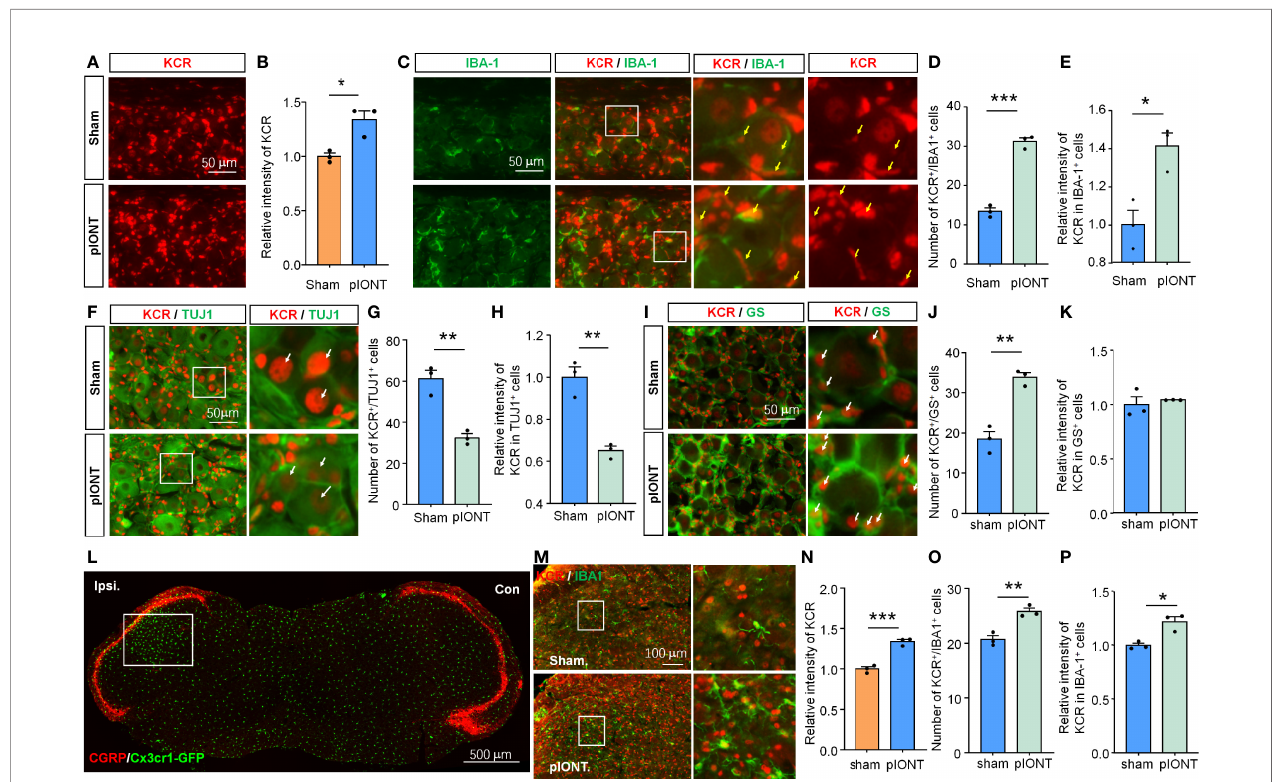
FIGURE 2 | The level of KCR in TG after pIONT was analyzed by quantitative immuno fl uorescence analysis. (A, B) Quanti fi cation of the total fl uorescence intensity of KCR in sham and pIONT TGs 7 days after surgeries. * P <0.05, n = 3 mice per group, 3 sections per mice, student ’ s t-test. (C) Representative TG sections double- labeled for IBA-1 and KCR from sham and pIONT groups. Yellow arrowheads point to IBA-1 and KCR double-positive cells, scale bar = 50 m m. (D, E) Bar diagram showing the number of KCR and IBA-1 double-positive cells (D) and KCR intensity in IBA-1 positive cells (E) . * P <0.05, *** P <0.001, n = 3 mice per group, 3 sections per mice, student ’ s t-test. (F) Representative fl uorescent pictures of TUJ1 and KCR in TG sections. Arrows (white) indicate KCR and TUJ1 double-positive cells, scale bar = 50 m m. (G, H) Bar diagram showing the number of KCR and TUJ1 double-positive cells (G) and KCR intensity in TUJ1 positive cells (H) . ** P <0.01, n = 3 mice per group, 3 sections per mice, student ’ s t-test. (I) Representative immuno fl uorescent staining of GS and KCR in TG sections. Arrows (white) indicate KCR and GS double-positive cells, scale bar = 50 m m. (J, K) Bar diagram showing the number of KCR and GS double-positive cells (J) and KCR intensity in GS positive cells (K) . ** P <0.01, n = 3 mice per group, 3 sections per mice, student ’ s t-test. (L) CGRP staining of the coronal medulla oblongata section from a Cx3cr1 - GFP mouse with infraorbital nerve injury indicates peripheral sensory innervation region in the medulla oblongata. The un fi lled rectangle represents the activated regions of the medulla oblongata after injury. Scale bar = 500 m m. (M) Representative immuno fl uorescent staining of IBA-1 and KCR of the activated regions of medulla oblongatas from sham and pIONT mice. Box highlights magni fi ed regions. Scale bar = 100 m m. (N – P) The statistical results of the total fl uorescence intensity of KCR (N) , the number of KCR and IBA-1 double-positive cells (O) , and the intensity of KCR in IBA-1 positive cells. * P <0.05, ** P <0.01, *** P <0.001, compared with the sham group. N = 3 mice per group, 3 sections per mice, student ’ s